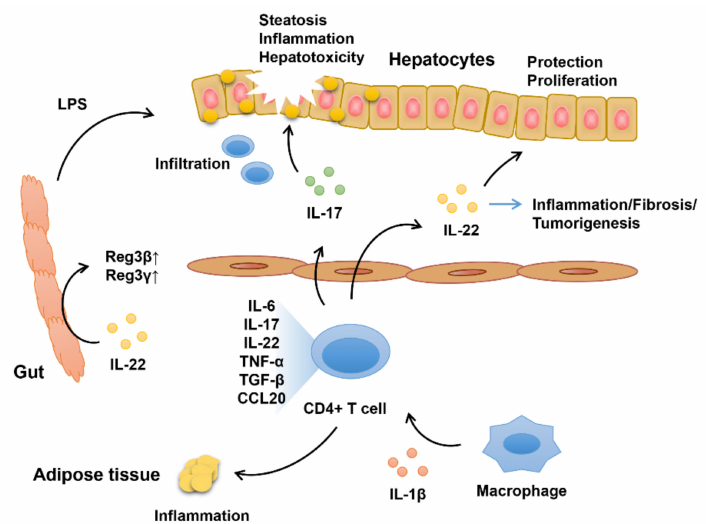
Figure 1. Schematics of roles of IL-22 on NAFLD. Expression of levels of IL-22 and IL-17 that secreted by infiltrating CD4+ T-helper cells is elevated. IL-17 accelerates inflammation and disease severity, whereas IL-22 exhibits tissue protection and proproliferation properties. However, concerns should also be taken since IL-22 might also participate in inflammation, liver fibrosis, and